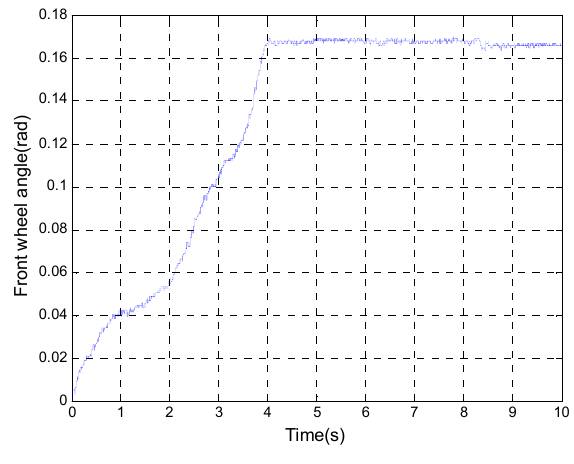
Figure 31. The front wheel angle.